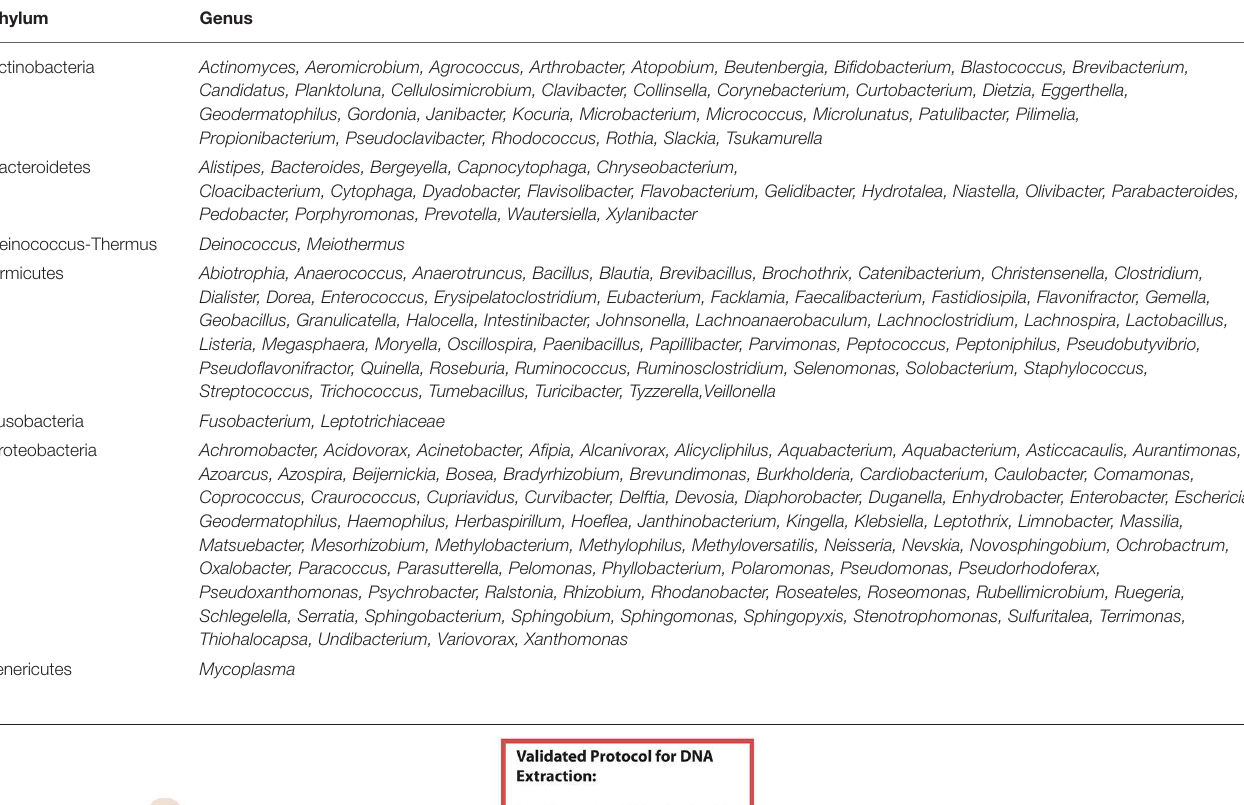
TABLE 2 | Previously identified bacterial contaminants.